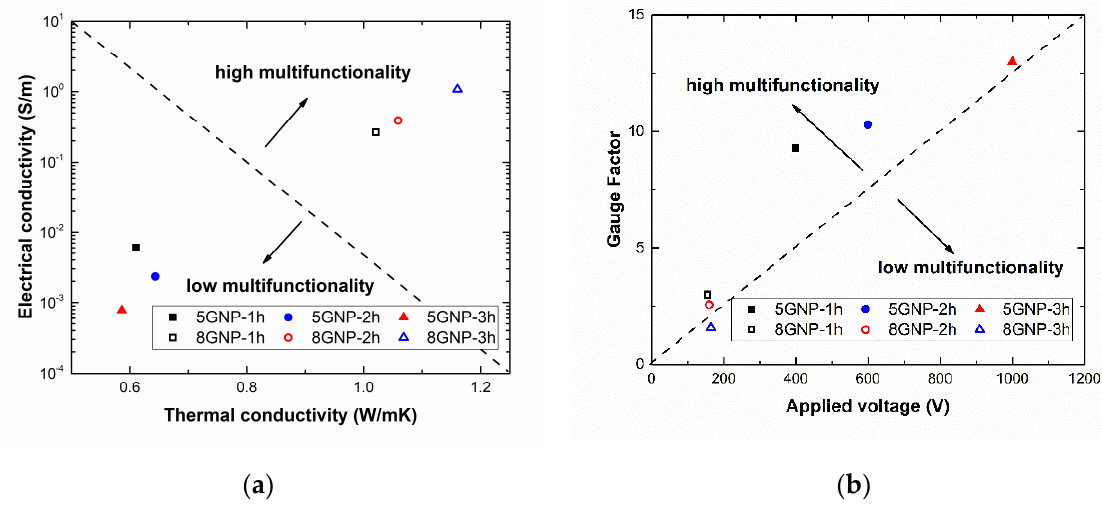
Figure 7. Graphs representing a comparison ( a ) between electrical and thermal conductivity and ( b ) between SHM capabilities, given by the Gauge Factor and Joule heating properties, given by the applied voltage to reach the maximum allowable